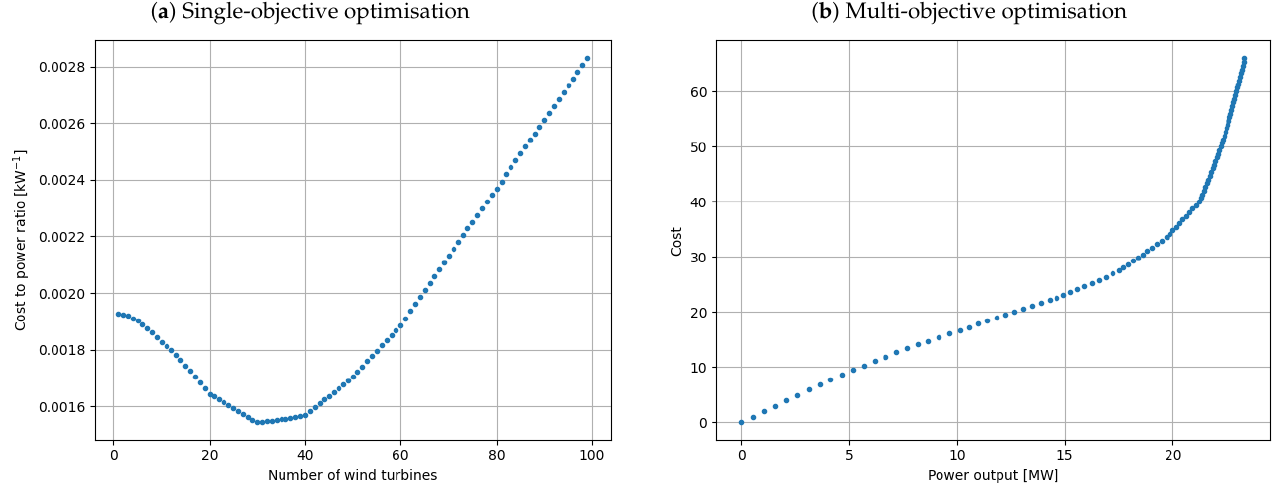
Figure 4. Transformation from single- to multi-objective